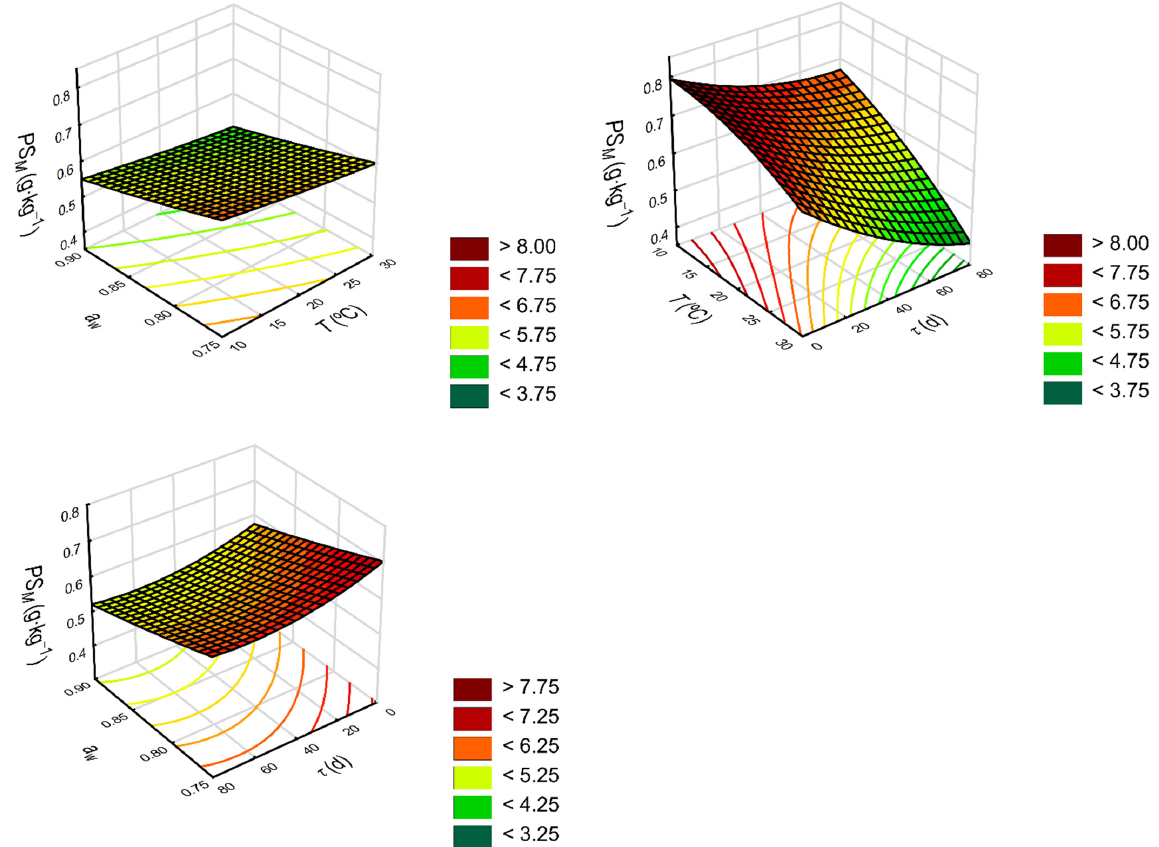
Figure 3. Response surface presenting the effects of temperature ( T ), water activity in seeds ( a w ) and storage time ( τ ) on phytosterol concentration ( PS M ).